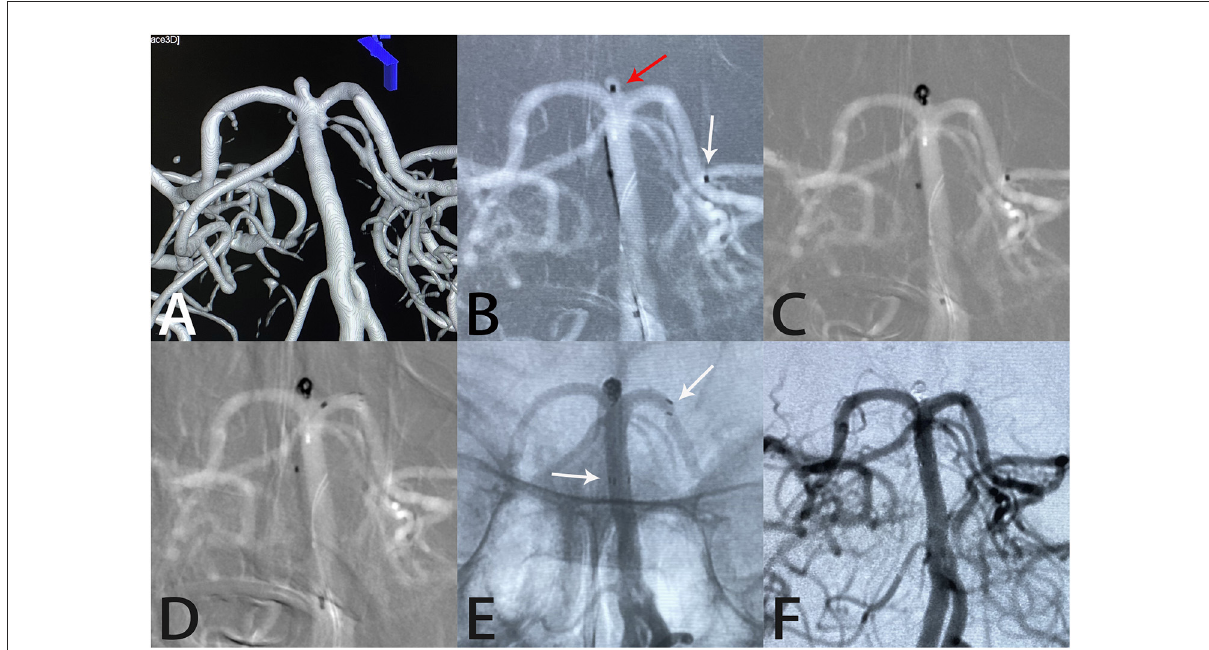
FIGURE4 Images from a 65-year-old woman with a tiny basilar artery aneurysm. Three-dimensional digital reconstruction angiography demonstrated a basilar artery aneurysm (A) . An Echelon-10 microcatheter was first navigated into the left posterior cerebral artery in preparation for deployment of the Atlas stent (white arrow); then, another Echelon-10 microcatheter was placed into the aneurysm sac (red arrow) for coil placement (B, C) . An Atlas stent (3.0 × 15mm) was deployed through another microcatheter to cover the aneurysm neck (D) . An unsubtracted image showed that the coils were packed densely within the sac and the Atlas stent was fitted well against the vessel wall (white arrows indicate the ends of the stent) (E) . Angiography immediately after the procedure showed complete aneurysm occlusion and unobstructed blood flow in the left posterior cerebral artery (F)